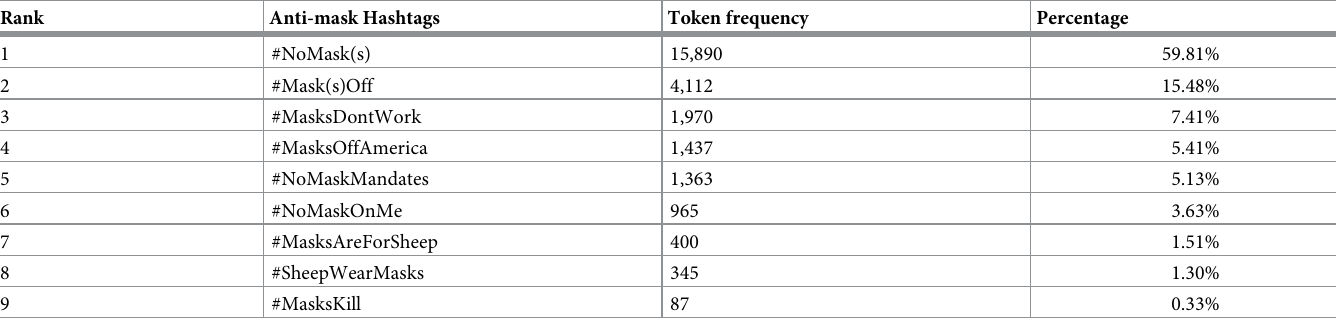
Table 2. Nine types of anti-mask hashtags ranked in token